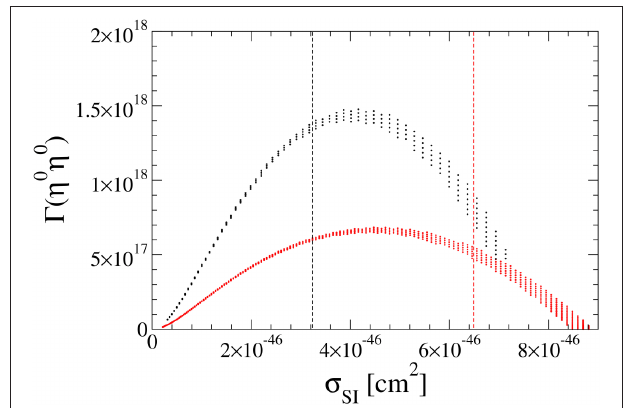
FIGURE 13 | The pair-annihilation rate of φ R into η 0 R η 0 R and η 0 I η 0 I in the Sun, t 0 ), against σ SI for m φ Ŵ ( η 0 η 0 ) Ŵ ( φ R φ R η 0 η 0 250 (black) and 500 R = = → ; (red) GeV, where m η is fixed at 230 GeV (all η s have the same mass) and h 2 < 0.123. The black (red) vertical dashed line is the XENON1T 0.117 < (cid:127) φ R 250 (black) and 500 (red) [ 103] upper bound on σ SI for m φ R =